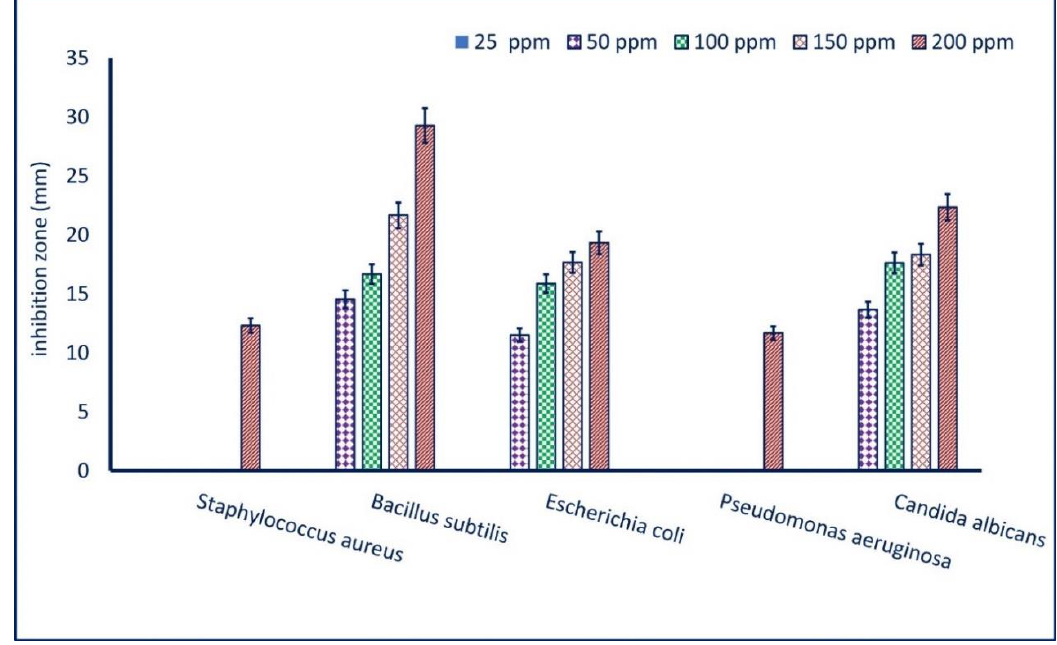
Figure 6. Antimicrobial activity of bacterially synthesized ZnO-NPs at different concentrations (200, 150, 100, 50, and 25 ppm) against Gram-positive bacteria ( B. subtilis and S. aureus ), Gram-negative bacteria ( E. coli and P. aeruginosa ), and unicellular fungi ( C. albicans ).